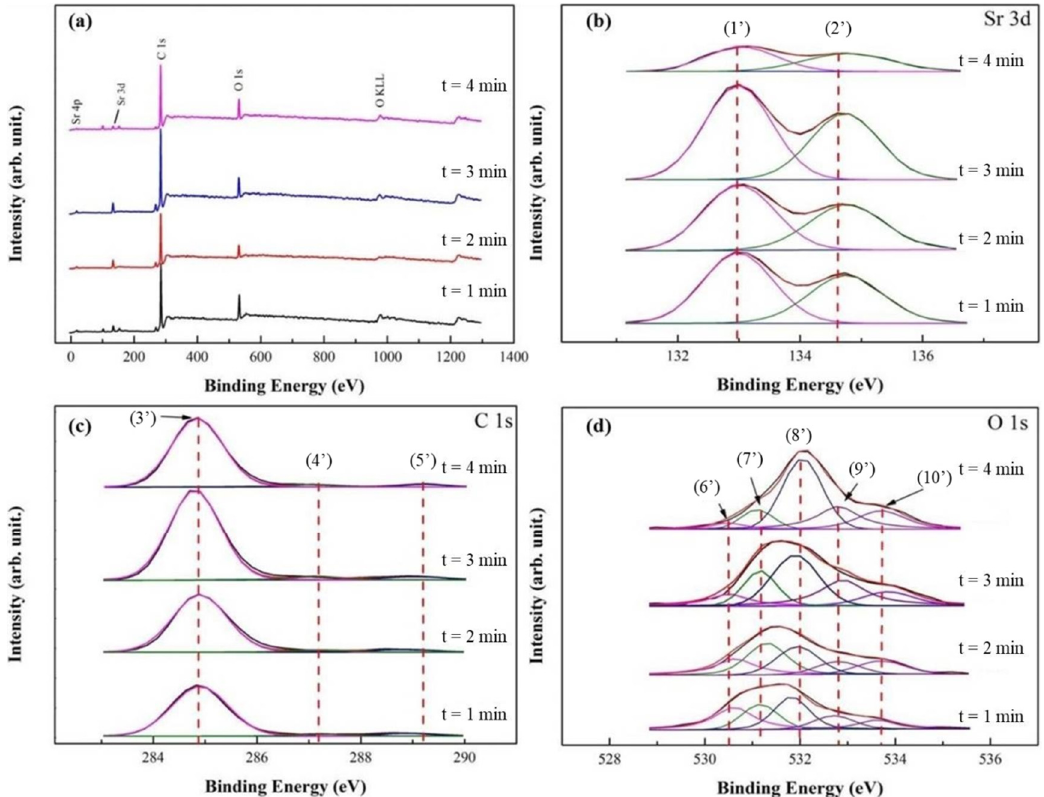
Figure 3. XPS studies of SrO_TiO 2 _P (0.5) after transesterification process with different reaction time (t, t = 1, 2, 3, or 4 min) were demonstrated: ( a ) wide-scan XPS spectra and ( b ) curve-fitted XPS spectra with different reaction time for ( b ) Sr 3d, ( c ) C 1s, and ( d ) O 1s. The curve-fitted peaks are respectively assigned at: (1) 132.9 eV, Sr 3d 5/2 , (2) 134.6 eV, Sr 3d 3/2 , (3) 284.8 eV, C-C, (4) 287.1 eV, C-O, (5) 289.2 eV, O=C-O, (6) 530.5 eV, Sr-O, (7) 531.0 eV, C-O, (8) 532.0 eV, M-OH, (9) 532.8 eV, C=O, and (10) 533.7 eV, O-C=O.